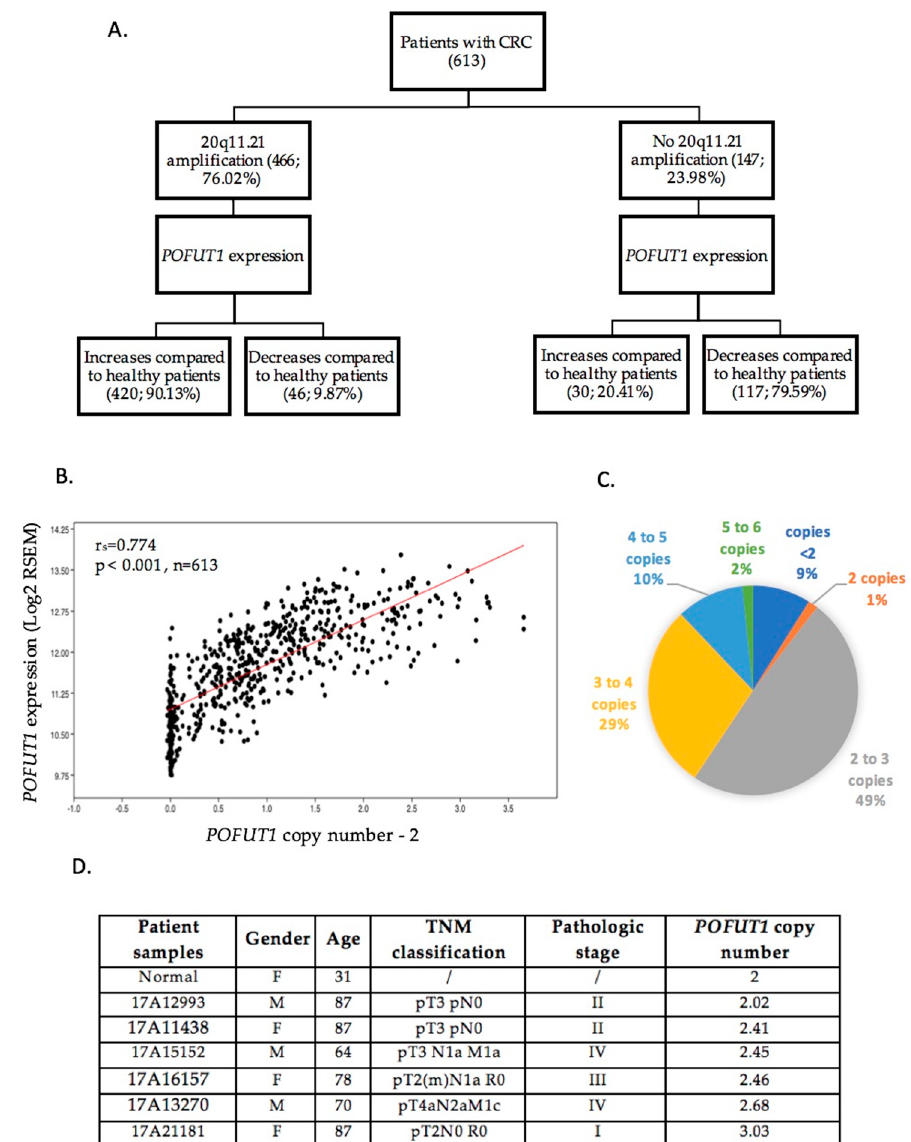
Figure 3. POFUT1 overexpression is strongly correlated with gene copy number variation. ( A ) Hierarchical analysis of 613 RNAseq data concerning POFUT1 shows that 76.02% of CRC patients have an amplification of 20q11.21 chromosomic region where POFUT1 is located. Among them 90.13% have a POFUT1 overexpression compared to the POFUT1 mean expression in non-tumor adjacent tissues. ( B ) Spearman Rho correlation analysis in 613 CRC patients shows that POFUT1 expression is significantly correlated with its copy number. To only view additional copies of POFUT1 gene, a subtraction of two copies corresponding to a physiological state is applied for each sample. ( C ) CRC patients have in the majority of cases between two and three POFUT1 gene copies. ( D ) POFUT1 copy number analysis performed on gDNA extracted from six CRC and one normal tissues shows an increase of POFUT1 copy number in five CRC cases compared to the normal sample.